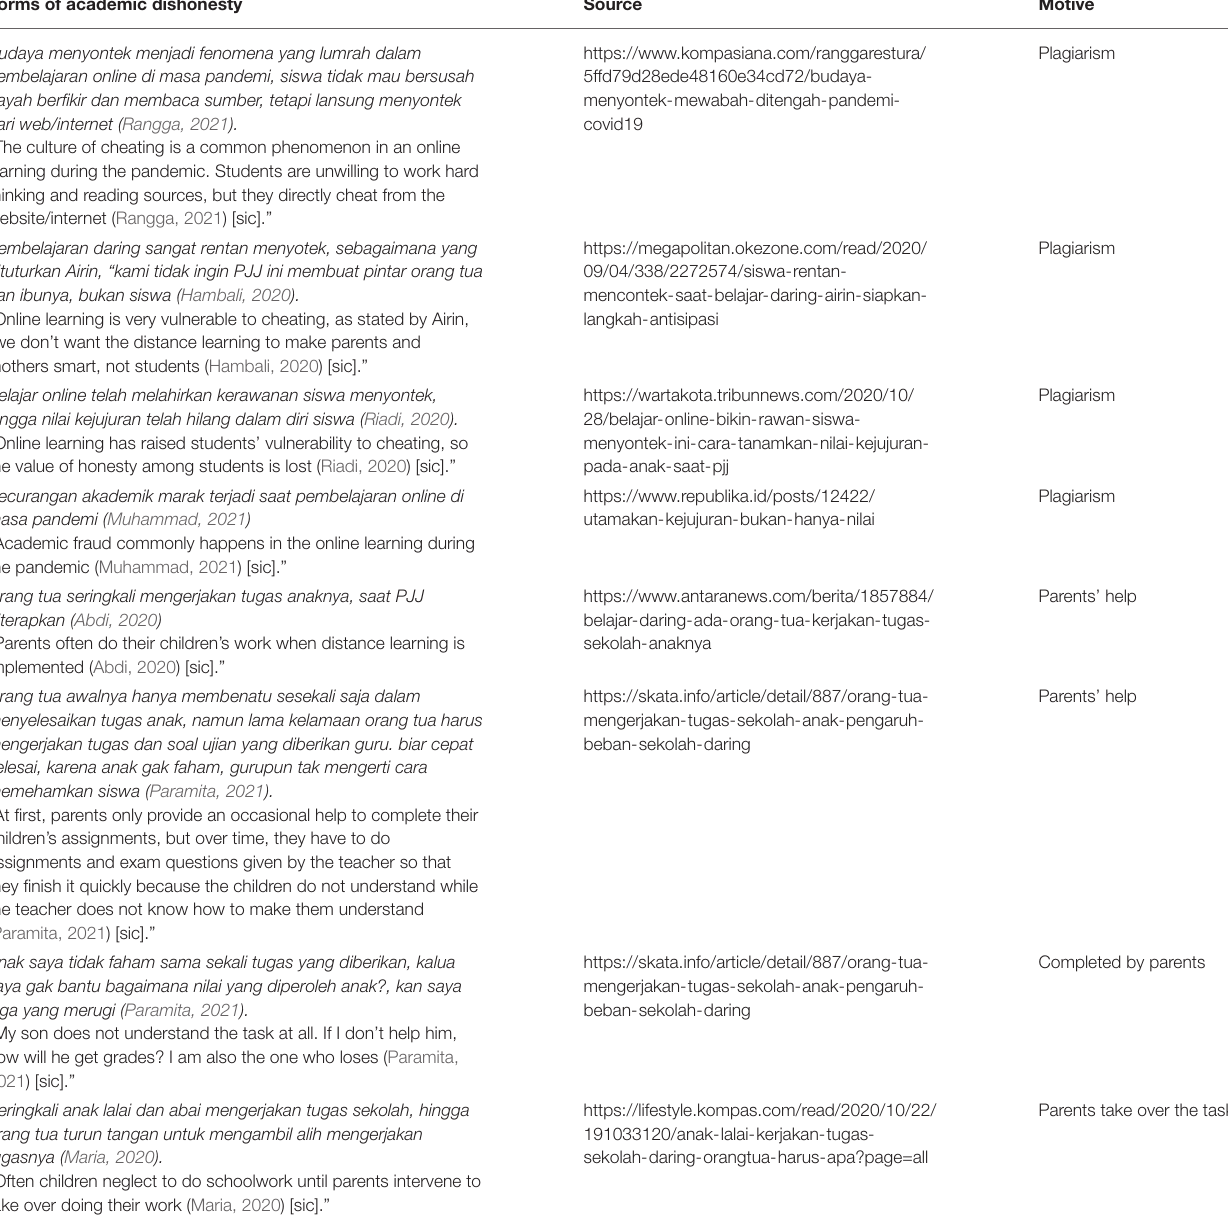
TABLE 2 | Academic dishonesty performed by students. Forms of academic